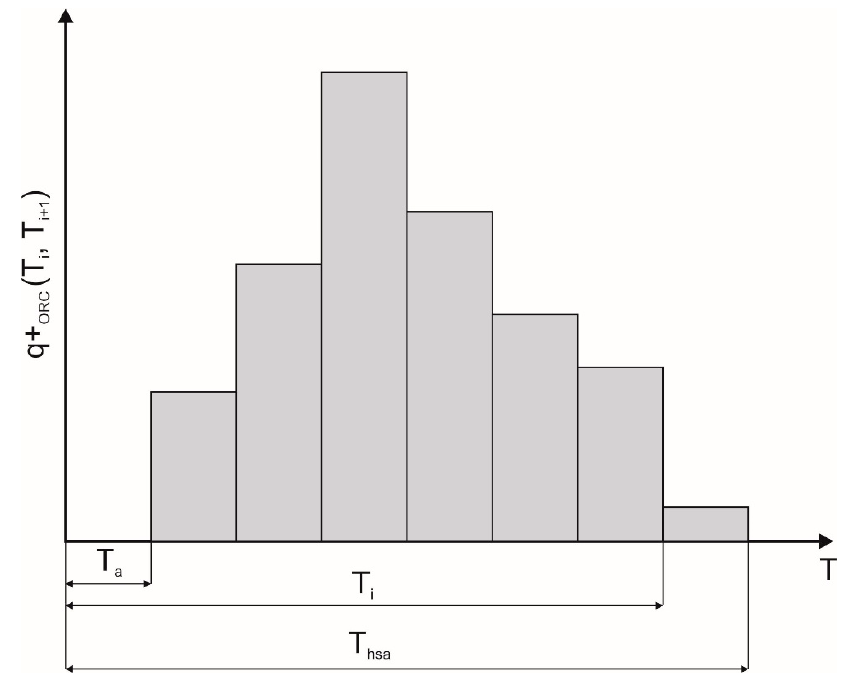
Figure 4. Example of the heat source histogram.